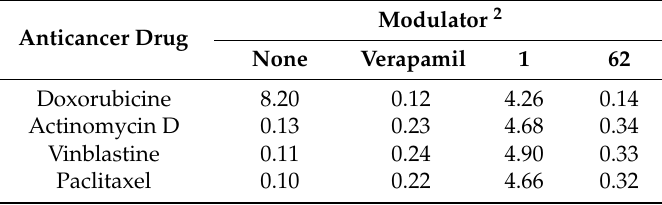
Table 11. MDR-reversing activity of compound 62 compared to quercetin and verapamil 1 .